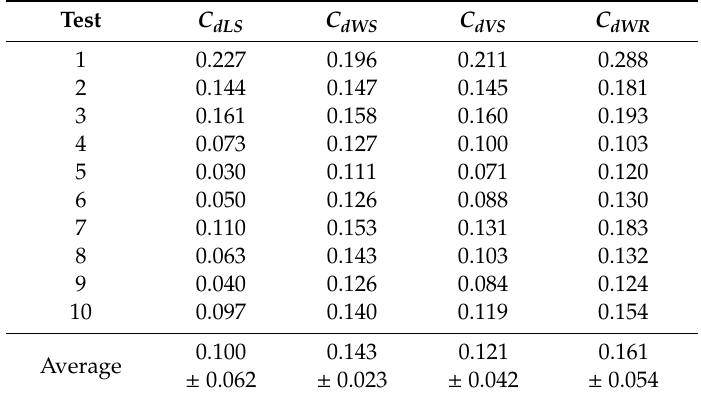
Table 5. Discharge coe ffi cients obtained at the vents of the experimental greenhouse. C dLS , leeward vent; C dWS , windward vent; C dVS , average coe ffi cient for side vents; C dWR , windward roof vent. Test C dLS C dWS C dVS C dWR